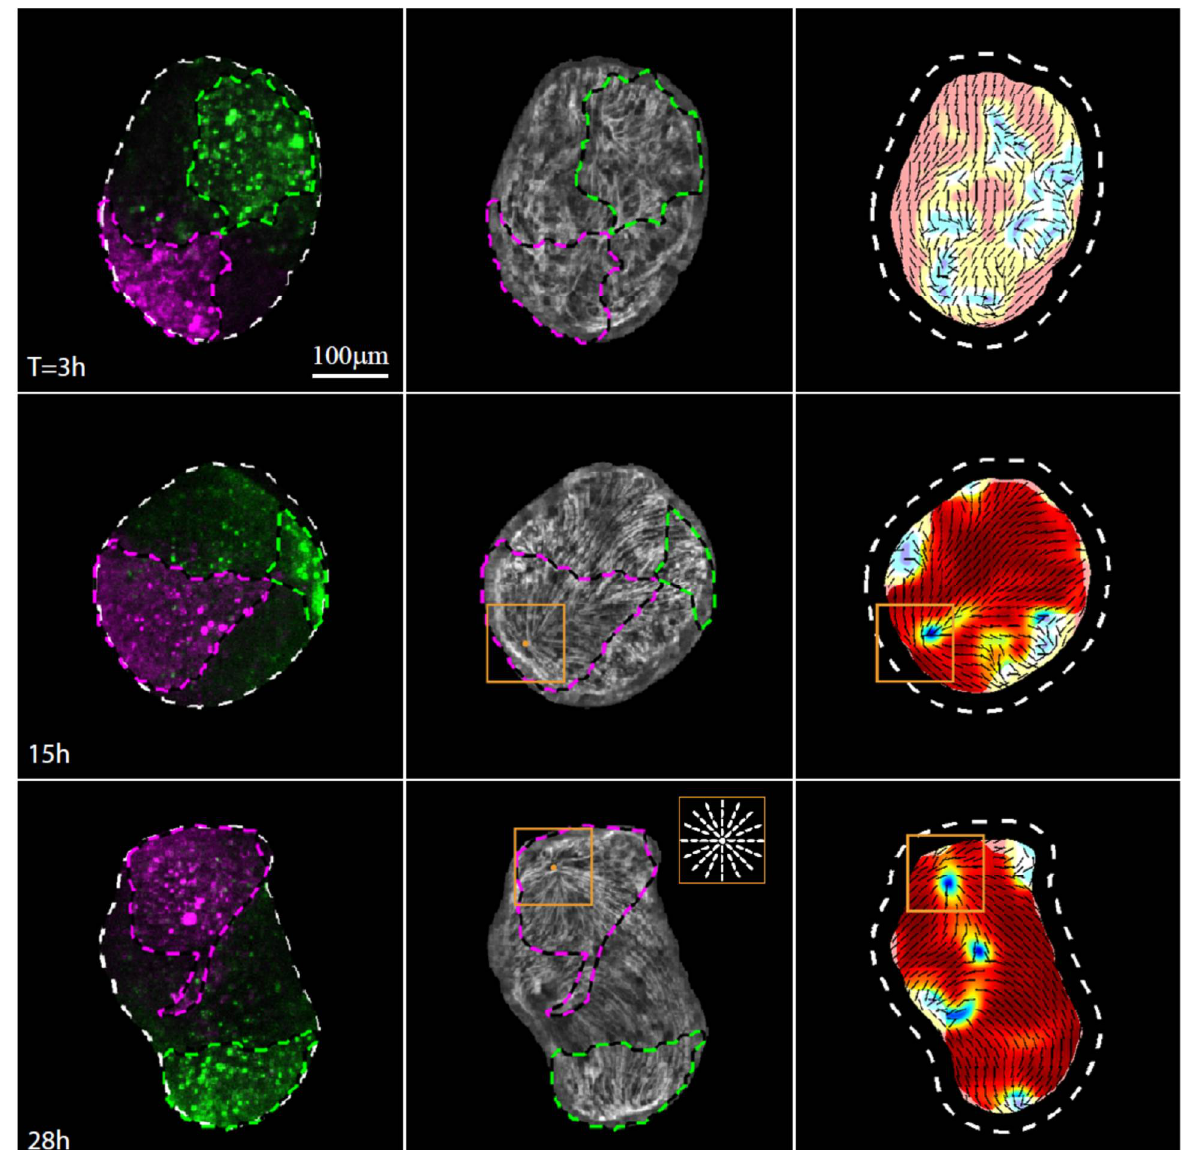
Figure 3. Actin fiber reorganization in the head region of a regenerating tissue strip. Images from a time-lapse movie (Movie S4) depicting the tissue dynamics and cytoskeletal organization in a regenerating tissue strip expressing lifeact-GFP in the ectoderm (gray) and differentially labeled at its head-facing side with uncaged Abberior CAGE 552 (magenta) and its foot-facing side with uncaged Abberior CAGE 635 (green). For each time point, images depicting an overlay of projected spinning disk confocal images of the fluorescent markers labeling the head-facing side of the strip (magenta) and the foot-facing side of the strip (green) are shown (left), together with an image of the supracellular ectodermal actin fibers on the basal surface (lifeact-GFP, gray) overlaid with contours depicting the labeled regions (middle), and a map of the corresponding actin fiber orientation (black lines) and local order parameter (color shading; see Methods [19]) with the tissue outline indicated by a dashed line. The location of the aster-like defect in the organization of the supracellular actin fibers that becomes the site of the mouth of the regenerated animal is denoted by an orange box. Inset: schematics showing the actin fiber organization in an aster-like (+1) defect. The actin fiber reorganization in the part of the tissue originating from the foot-facing side of the strip is consistently different from that in the tissue originating from the head-